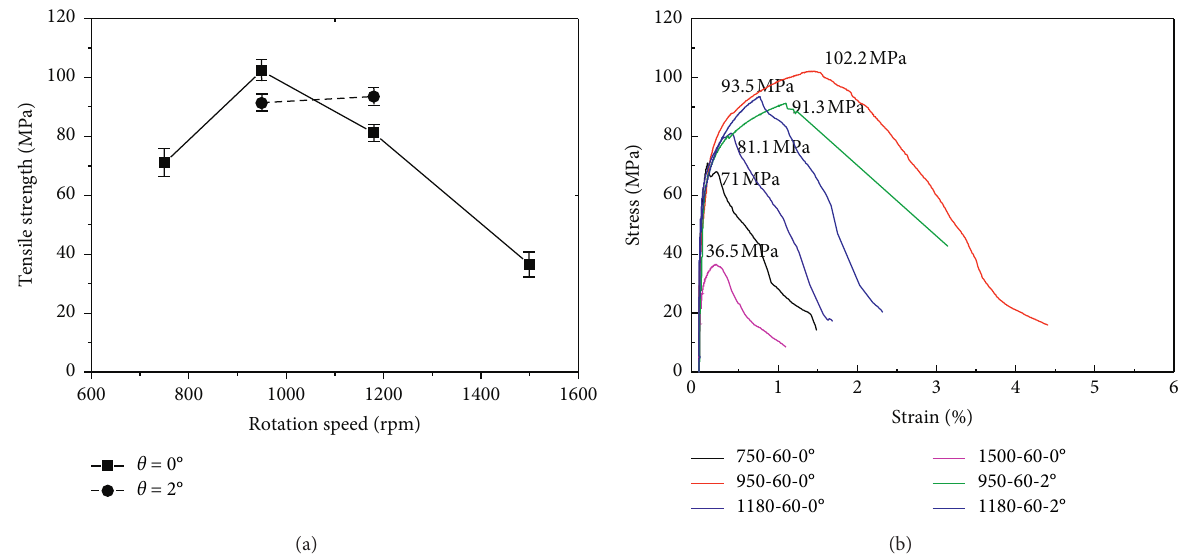
Figure 6: The joint strength and the typical stress-strain curve shown as (a) the strength of the joint procured by different parameter and (b) the corresponding stress-strain